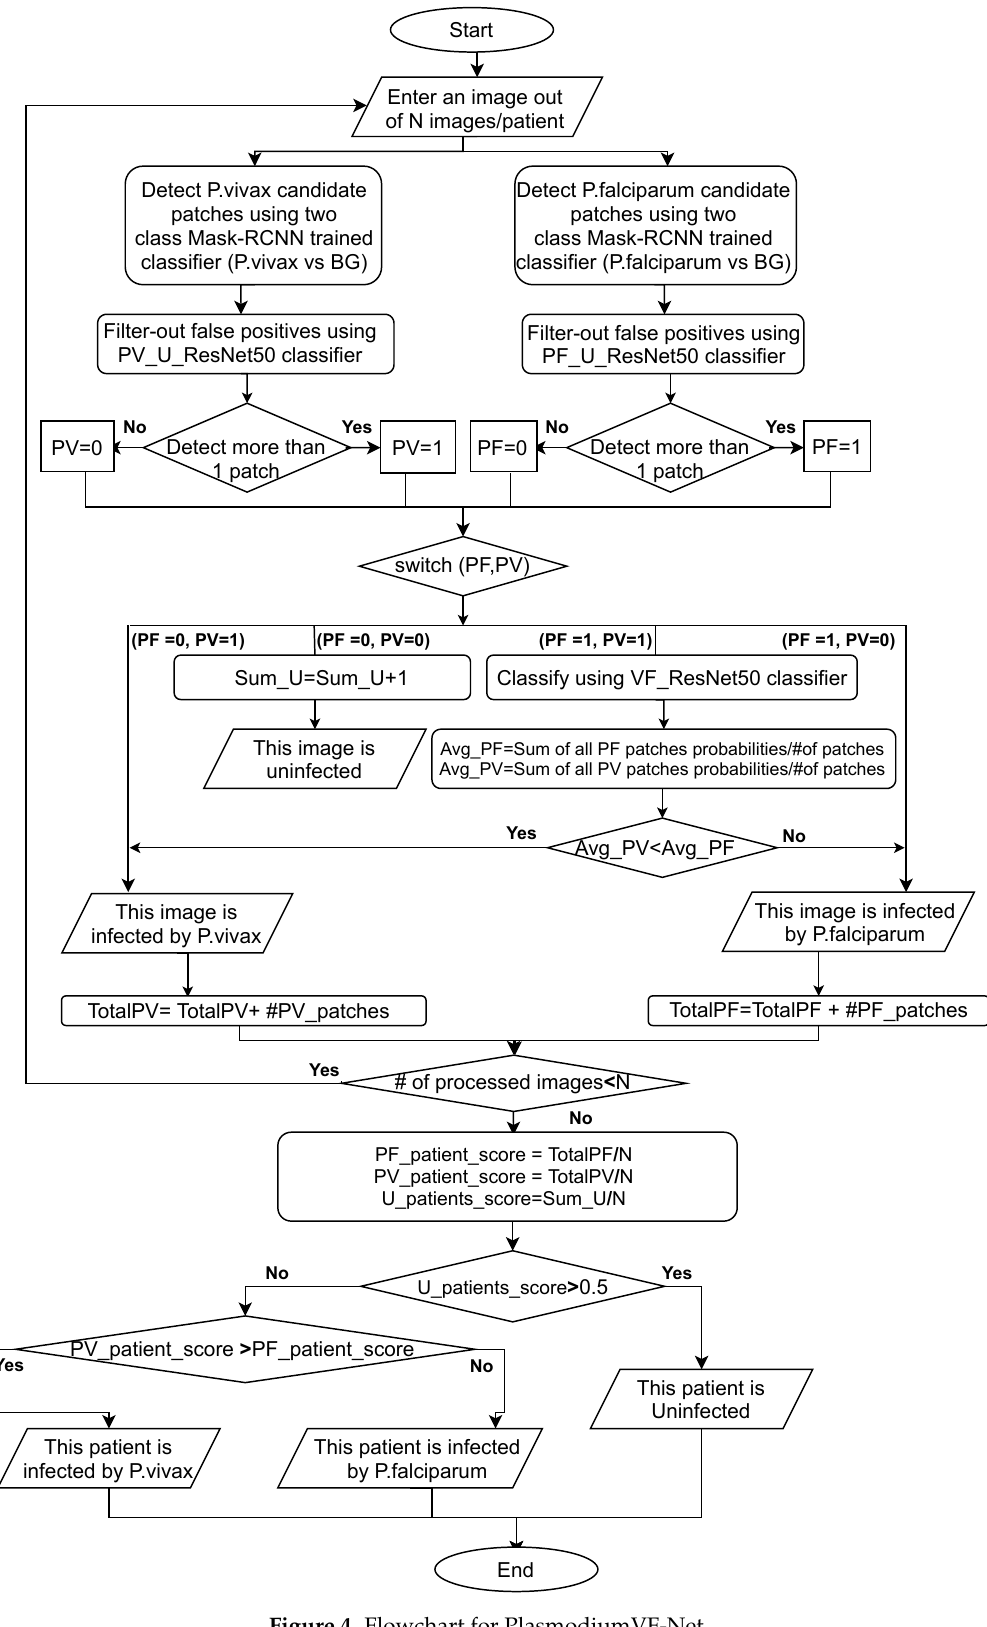
Figure 4. Flowchart for